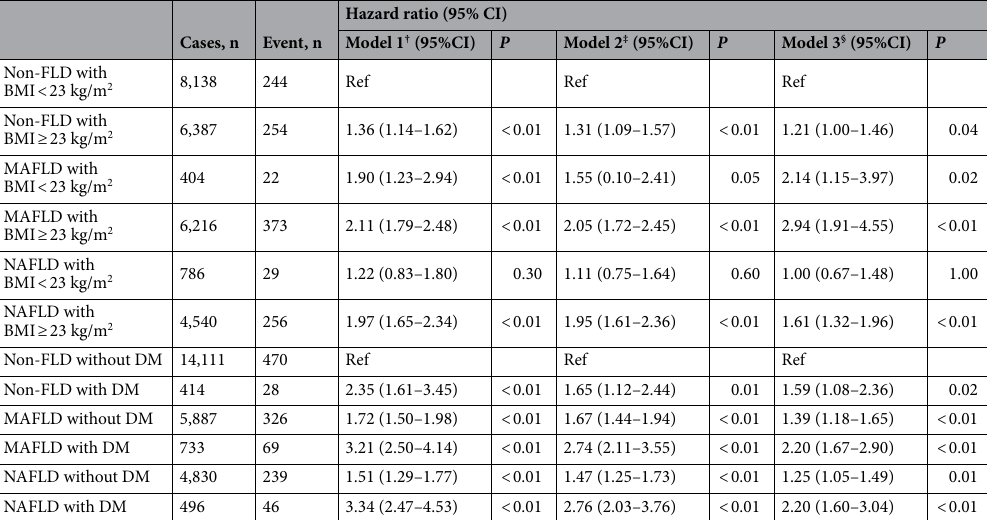
Table 3. Associations between BMI and DM and the incident CKD in subjects with MAFLD or NAFLD. BMI body mass index, CI confidence interval, CKD chronic kidney disease, DM diabetes mellitus, MD metabolic dysregulation, MAFLD metabolic dysfunction–associated fatty liver disease, NAFLD nonalcoholic fatty liver disease. The MAFLD group consists of both-FLD (n = 4,844; same as MAFLD with MD only group) and MAFLD-only (n = 1,776) groups, and the NAFLD group consists of both-FLD (n = 4,844) and NAFLD-only (n = 482) groups. † Model 1 was crude. ‡ Model 2 was adjusted for age and sex. § Model 3 was adjusted for age, sex, estimated glomerular filtration rate, smoking, physical activity, prediabetes, diabetes, hypertension, cardiovascular disease, NAFLD fibrosis score, body mass